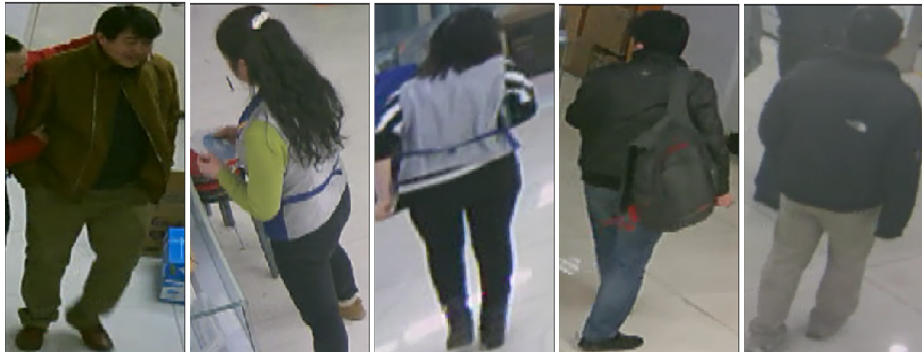
Figure 6. Sample images of RAP v2 dataset.